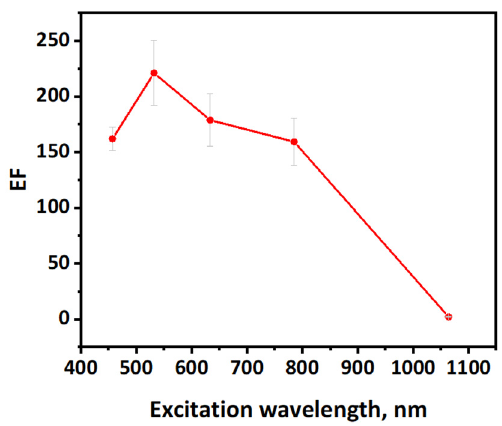
Figure 8. Calculated SERS enhancement factor (EF) for 2 mM salicylic acid dried on the MXene film with different excitation wavelengths.